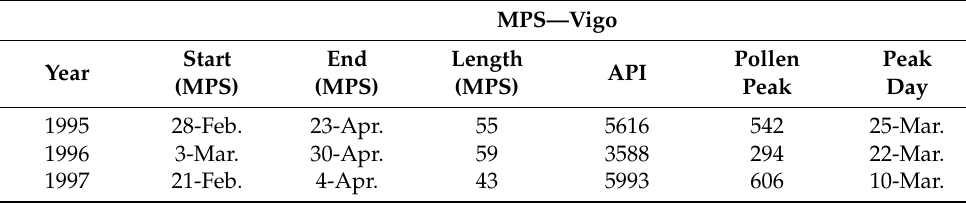
Table 1. Pinus MPS during the 25 study years in the Eurosiberian area (Vigo): start date, end date, length, API (pollen grains), daily pollen peak (pollen grains/m 3 ) and peak date. Average, minimum and maximum values, standard deviation (SD) and relative standard variation in percentage (%RSD) are included. The logistic method was